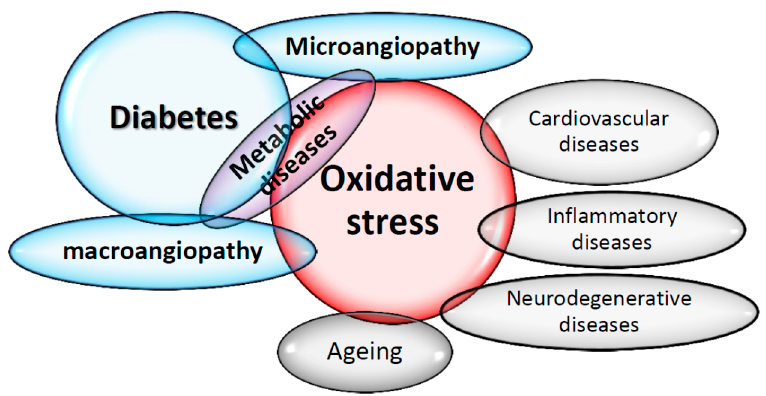
Figure 1. Oxidative stress in the middle of diseases and complications, including diabetes.